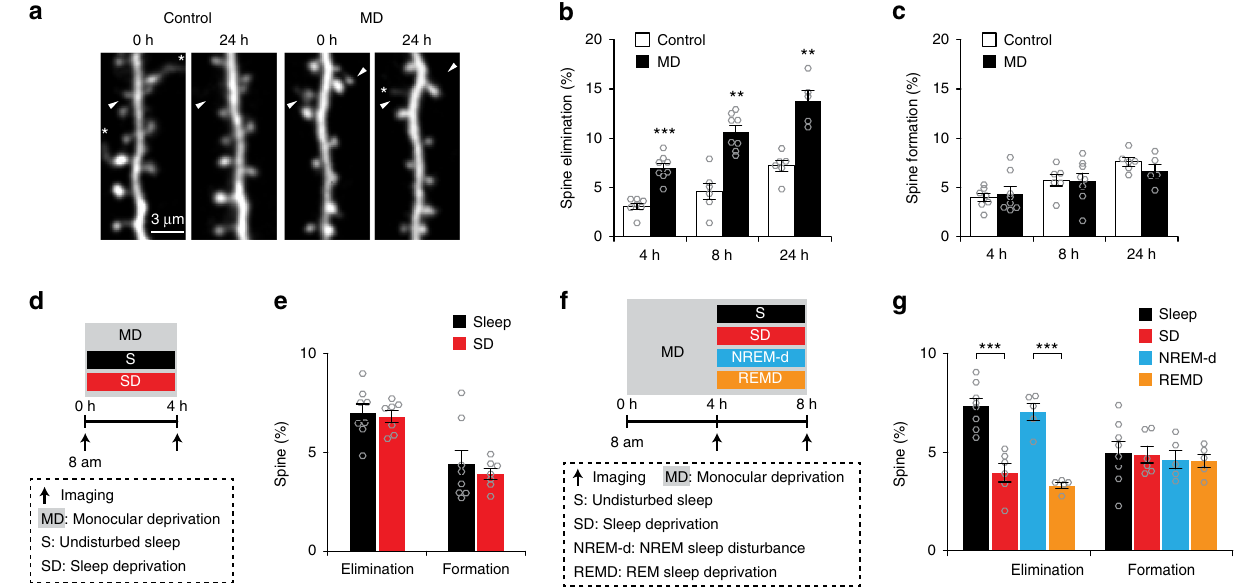
Fig. 1 SD or REMD reduces MD-induced spine elimination in V1. a Repeated imaging of dendritic spines on apical tuft dendrites of layer 5 pyramidal neurons in MD and non-deprived control mice. White arrowheads indicate eliminated spines, asterisks indicate fi lopodia. Scale bar: 3 μ m. b Dendritic spine elimination was signi fi cantly higher in MD mice than in control mice over 4 – 24 h (control: n = 7, 6 and 6 mice for 4, 8, and 24 h, respectively; MD: n = 8, 8 and 5 mice for 4, 8, and 24 h, respectively; P = 0.0003, = 0.0013 and = 0.0043 for 4, 8, and 24 h, respectively, Wilcoxon – Mann – Whitney test, two-sided). c No signi fi cant difference in dendritic spine formation between MD and control mice (control: n = 7, 6 and 6 mice for 4 h, 8 h and 24 h, respectively; MD: n = 8, 8 and 5 mice for 4, 8, and 24 h, respectively; P = 0.817, = 1.000, and = 0.361 for 4, 8, and 24 h, respectively, Wilcoxon – Mann – Whitney test,